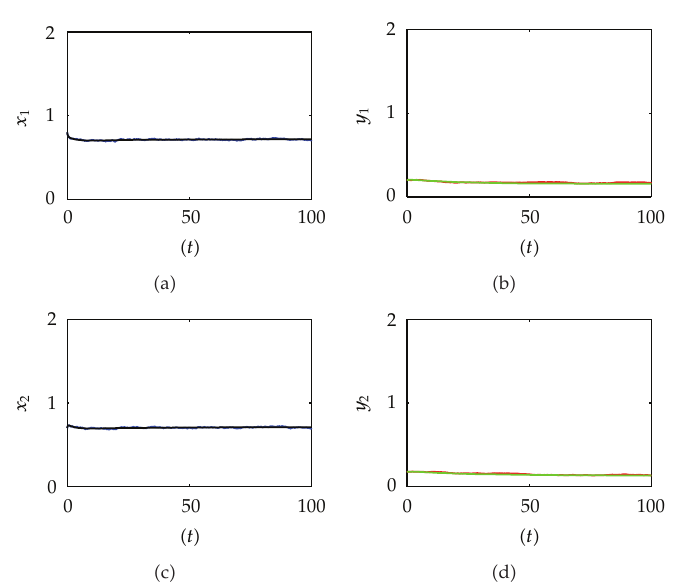
Figure 3: The solution of stochastic system compared to the deterministic system: σ 11 (cid:5) σ 12 (cid:5) σ 21 (cid:5) σ 22 (cid:5) 0 . 01. The blue and red lines represent the solutions of system (cid:2) 5.1 (cid:3) , and the black and green lines represent the solutions of corresponding undisturbed system. These lines are almost coincident.